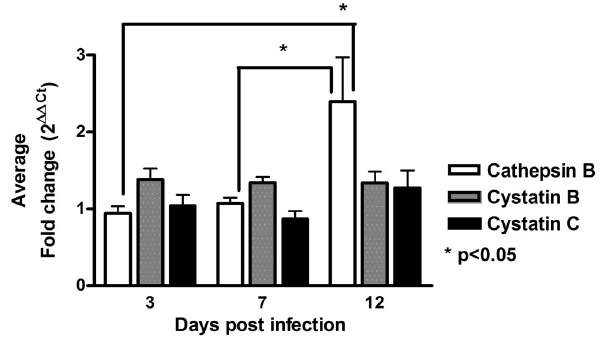
Figure 1. Increased cathepsin B mRNA after HIV infection. MDM from 8 different donors were inoculated with HIV-1 ADA or with serum- free media (uninfected controls) for 12 days and cell pellets collected at 3, 7, and 12 days post-infection. Changes in mRNA levels are shown as Fold change =2 DD Ct =2 ( D Ct control – D Ct experimental) for cathepsin B (white), cystatin B (grey), and cystatin C (black). The mRNA levels of cystatins B and C remained similar after HIV infection. A significant increase in mRNA expression was found for cathepsin B in HIV infected MDM at 12 days compared to 3 (*p=0.038, B) and 7 dpi